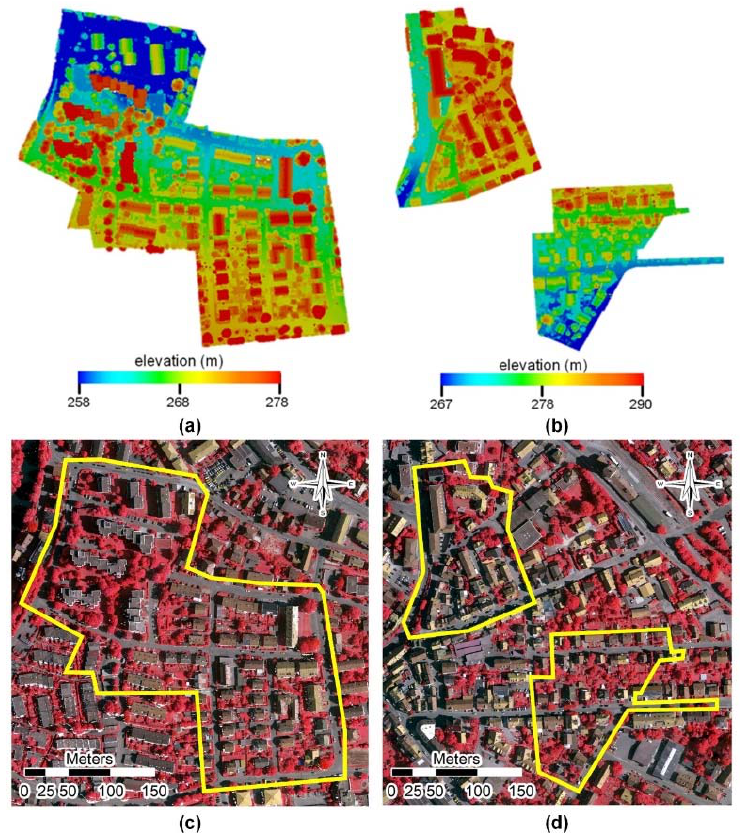
Figure 4. Data used in this study. ( a ) LiDAR training data; ( b ) LiDAR testing data; ( c , d ) corresponding optical multispectral imagery of LiDAR training and testing data.